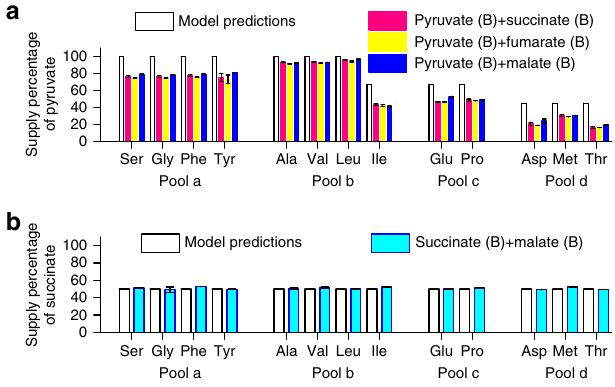
Fig. 4 Suppliers of precursor pools in B + B cases. Vertical axes are the percentages of the carbon atoms from the fi rst of the two sources indicated. Model predictions (in hollow bars, see Supplementary Table 4) are shown together with experimental results (in color bars). The source supplier of representative amino acids in Pools a – d was measured using 13 C labeling (raw data from M-57 fragment; see Methods for details). Error bars represent standard deviations. Source data are provided as a Source Data fi le. a Pyruvate mixed with another Group B carbon